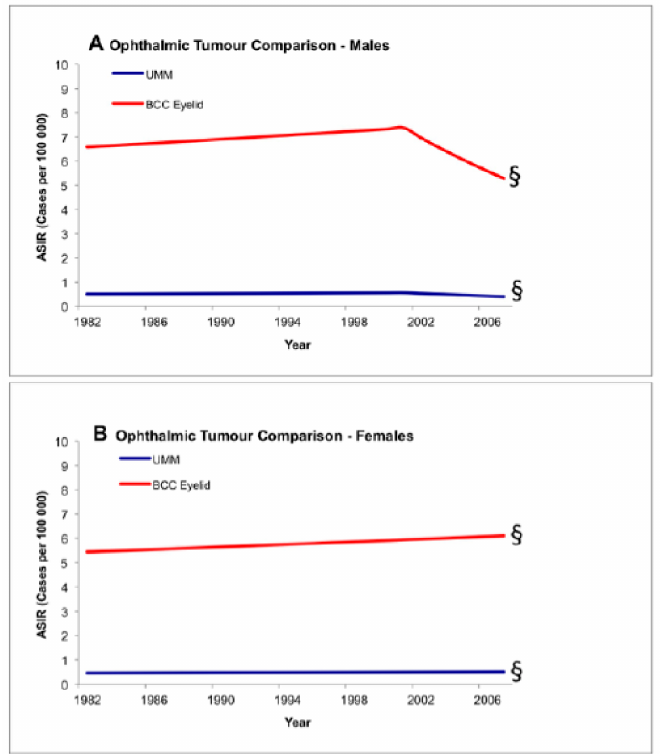
Figure 2. Test of parallelism comparing incidence trends between ocular tumors using registry data, 1982–2007. There is no statistically significant increase in the incidence of basal carcinoma of the eyelid and uveal melanoma. § Denotes parallel trend ( p < 0.05). ASIR: age-standardized incidence rate; BCC: basal cell carcinoma; UMM: uveal malignant